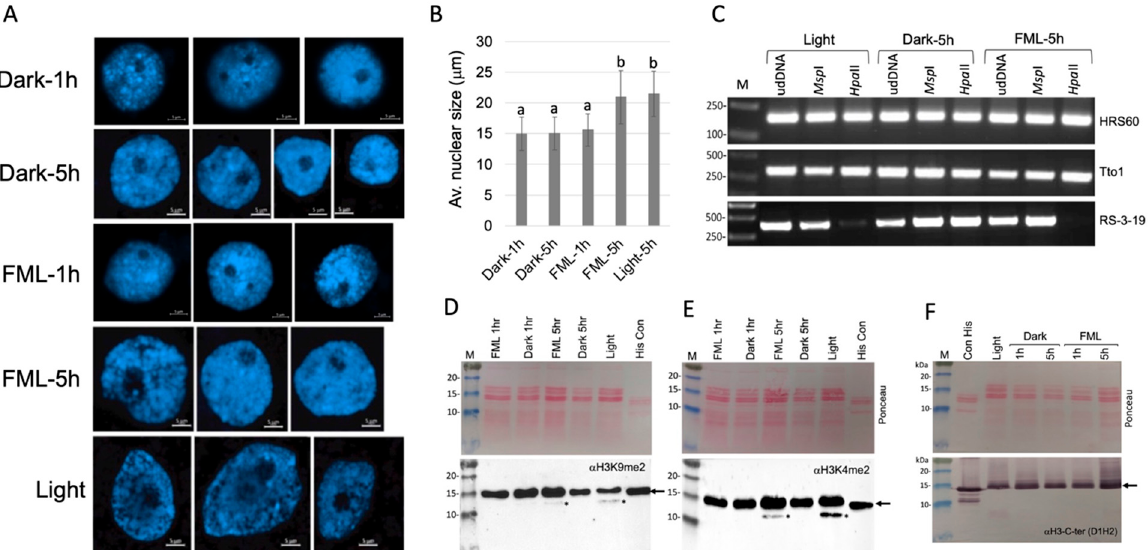
Figure 1. FML induces changes in nuclear size. ( A ) Leaves of tobacco plants exposed to dark, light or FML for 1 h or 5 h were fixed in acetic acid–ethanol (1:3), and nuclei were prepared, stained with DAPI and visualized under a confocal microscope. ( B ) Average diameter of nuclei prepared from dark-, light- and FML-treated plants ( n = 100). Vertical bars represent the standard deviation. Statistical significance was determined with a One-Way ANOVA Calculator, Including Tukey HSD (Social Science Statistics). Different letters indicate statistically significant differences between treatments ( p < 0.01). ( C ) Exposure to light and FML was accompanied by a reduction in CG methylation at centromeric repeats. Genomic DNA extracted from plants exposed to light, 5 h of dark and 5 h of FML was digested with Hpa II or Msp I and subjected to PCR to amplify HRS60, Tto1 and RS-3-19 sequences. Undigested DNA (Ud DNA) was used as a reference. The experiment was repeated 3 times. M indicates the DNA size marker given in base pairs. ( D – F ) Light and FML induced C-terminal cleavage of histone H3. Acid-soluble fractions from leaves derived from light-, dark- and FML-exposed tobacco plants were analyzed via immunoblotting to detect the indicated modified histone H3, dimethyl H3K9 ( α H3K9me2) ( D ), dimethyl H3K4 ( α H3K4me2) ( E ) and histone H3 using antibody to the C-terminal region ( α H3-C-ter) ( F ). Upper panels show Ponceau staining of membranes. Asterisks indicate the fast-migrating isoforms and arrows the major H3 isoforms. Con His represents control histone proteins from calf